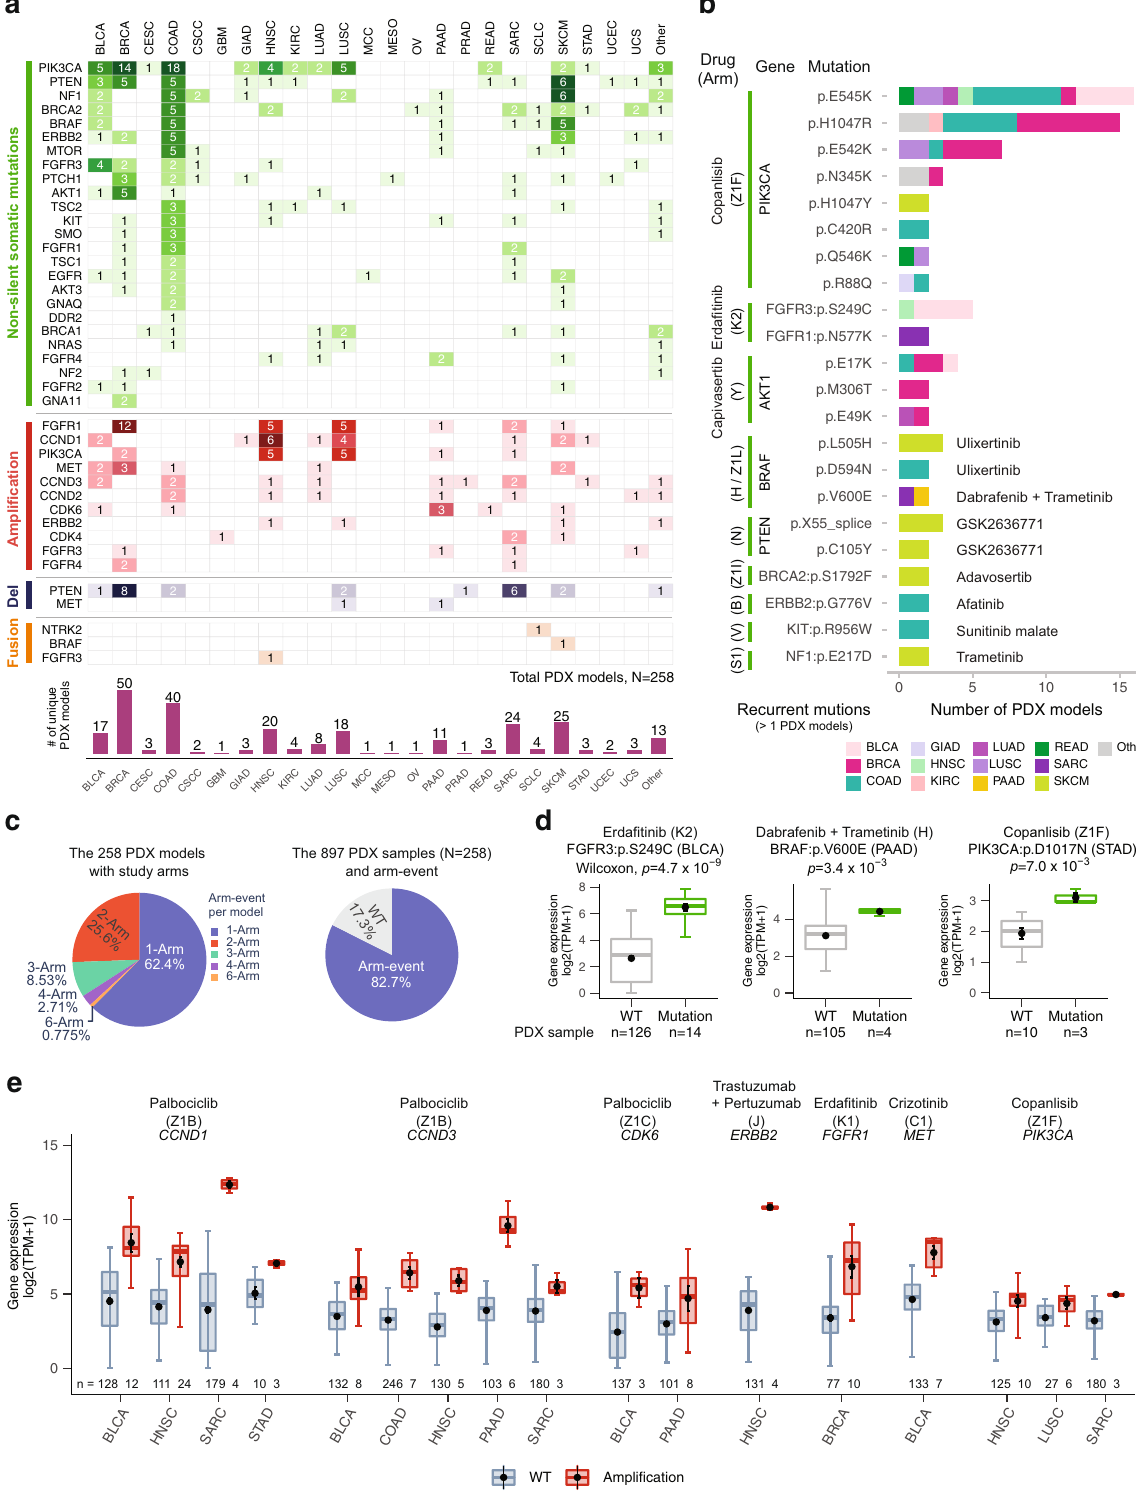
swap/mismatch/contamination across a collection of samples by correlating variant allele frequencies of a target set of germline SNPs. The target SNP markers were selected from ~5 million common missense SNPs (dbNSFP v3.5a; https://sites. google.com/site/jpopgen/dbNSFP and Pengelly et al., 2013 71 ) across chromosomes 1 – 22 in the human genome based on WES and RNA-Seq data testing. Filtering out contaminated or swapped samples using GermlineQC resulted in good agreement with short tandem repeat (STR) polymorphism data. For samples remaining ambiguous after GermlineQC, we applied HLA-QC. HLA-QC uses